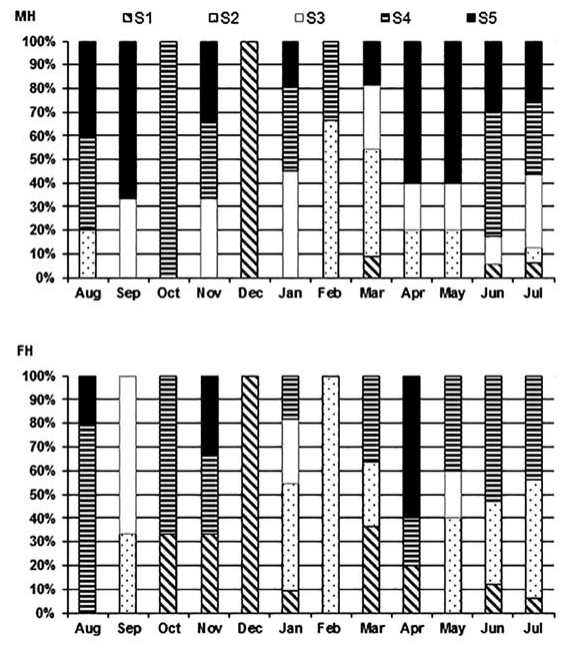
Fig. 7. – Percentage of different stages in male hermaphrodite (MH) and female hermaphrodite (FH) of Ostrea edulis from August to July (early developing (S1), developing (S2), ripe (S3), partly spawned (S4) and fully spawned